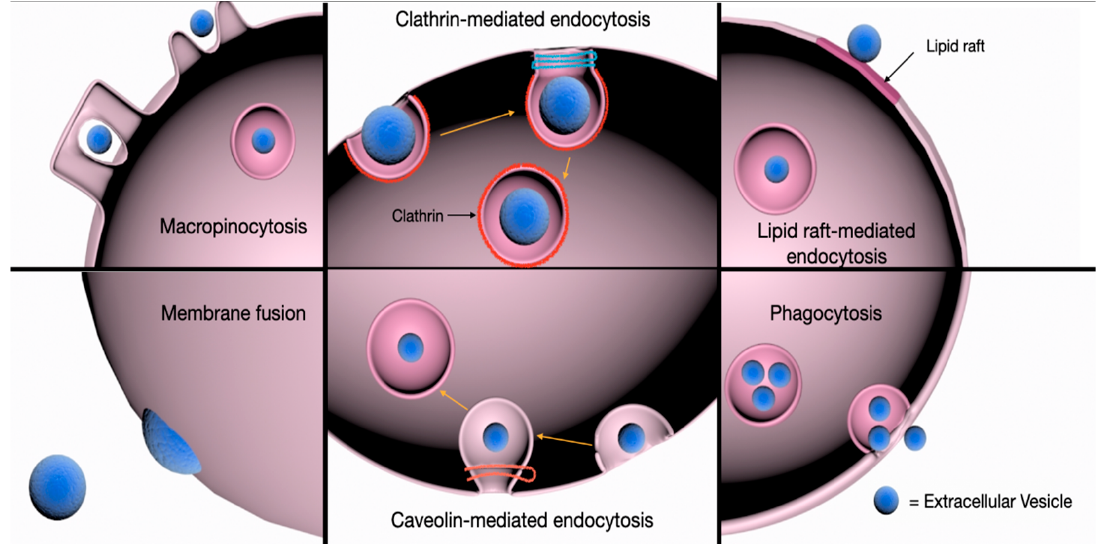
Figure 2. Schema of the pathways involved in EV uptake by recipient cells. EVs can be internalized into target cells via clathrin- and caveolin-mediated endocytosis, phagocytosis, and macropinocytosis. The role of lipid rafts in clathrin- and caveolin-dependent and -independent endocytosis of EVs has also been described. Alternatively, EV cargo may be internalized following the direct fusion of EVs with the plasma membrane of target cells to induce phenotypic responses.